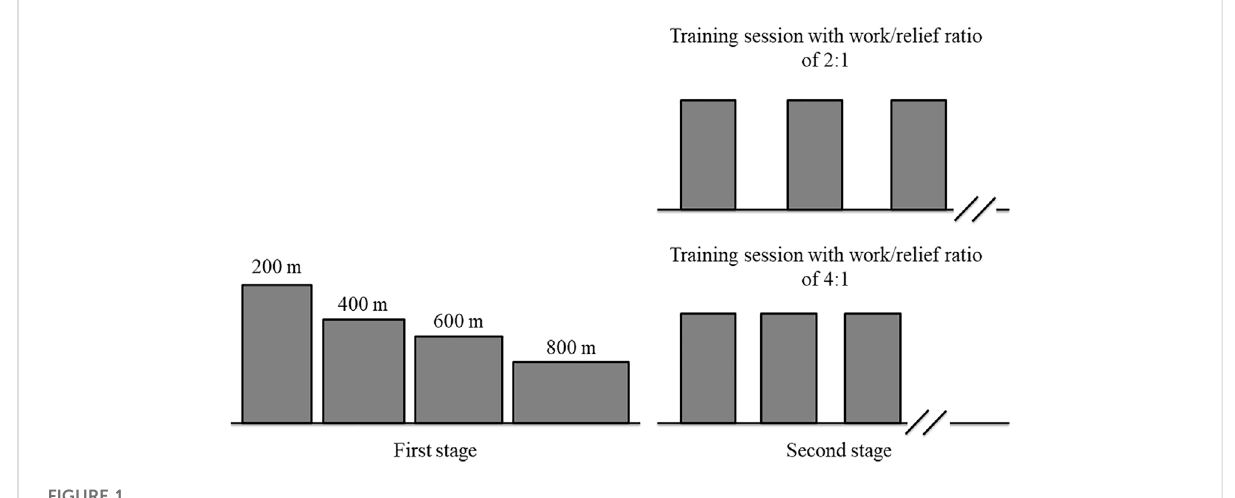
Schematic illustration of experimental